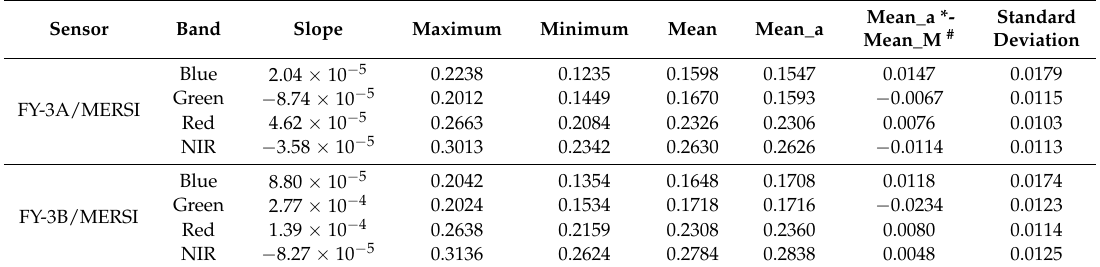
Mean_a *- Standard Mean_M # Deviation